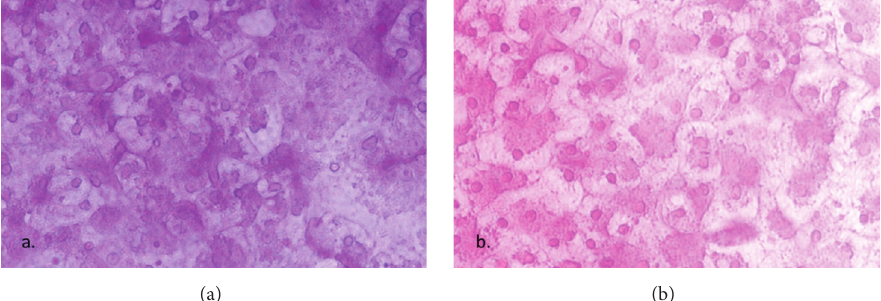
Figure 19: Representative PAS stainings. The cells were treated with periodic acid, SCHIFF, and hematoxylin as described in Materials and Methods. (a) P11025 and (b)